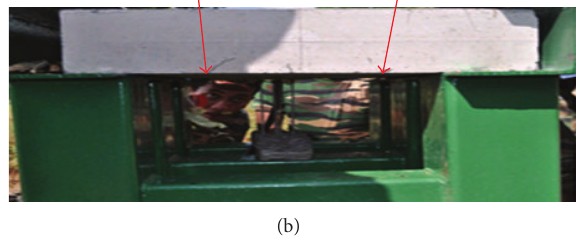
Figure 12: (a) Simulation results for HSFRC panel. (b) Experiment results for HSFRC panel.